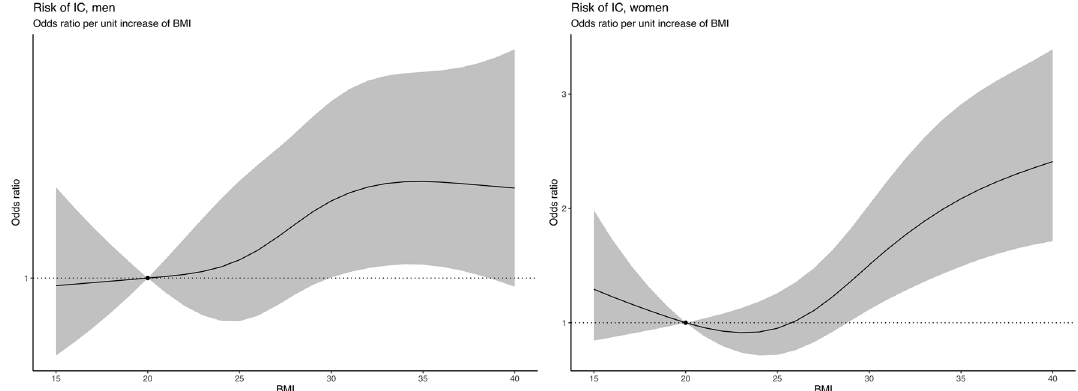
Figure 5. Age adjusted odds ratios (95% CI) of IC by unit of increase in BMI with BMI 20 kg/m 2 as a reference, for men (left) and women (right). BMI body mass index, IC intensive